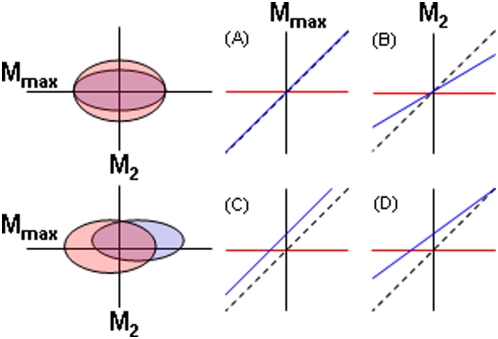
Comparing morphological diversity using ordered-axis plots.Ordered-axis plots discriminate between different patterns of morphological diversity along axes of a multidimensional morphospace. In this example species of two adaptive radiations with the same number of observations are represented by clouds of red (older, more diverse) and blue (younger, less diverse) points in two dimensional morphospaces defined by Mmax and M2. When their values along an axis are independently ordered from smallest to largest then combined to form a set of x-y points, the slope and intercept (int.) of the linear regression of y (blue) on x (red) discriminate between four possible arrangements along that axis. The dotted line is slope = 1. Top: (A) along Mmax the radiations are centered at the same point (i.e. convergent) so the int. = 0, and equally diverse, so the slope = 1; (B) along M2 the radiations are again centered at the same point (convergent, int. = 0) but the older radiation is more diverse so the slope of the regression of y on x is <1. Bottom: (C) along Mmax the radiations are centered at different points along the axis (non-convergent, int.≠0) but have equal levels of diversity (slope = 1); (D) along M2 the radiations are non-convergent (int.≠0) and the older radiation is more diverse (slope<1).